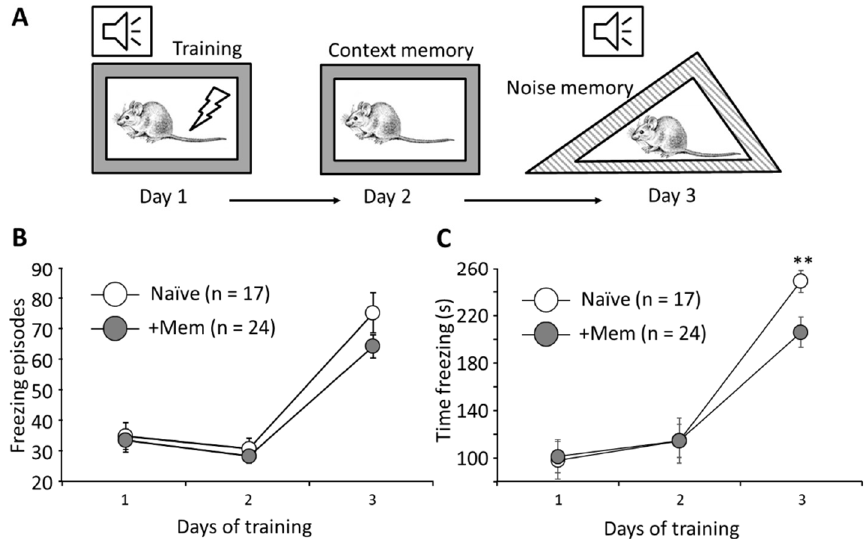
Figure 2. Memantine impairs memory in a fear conditioning paradigm. ( A ) Schematic of the